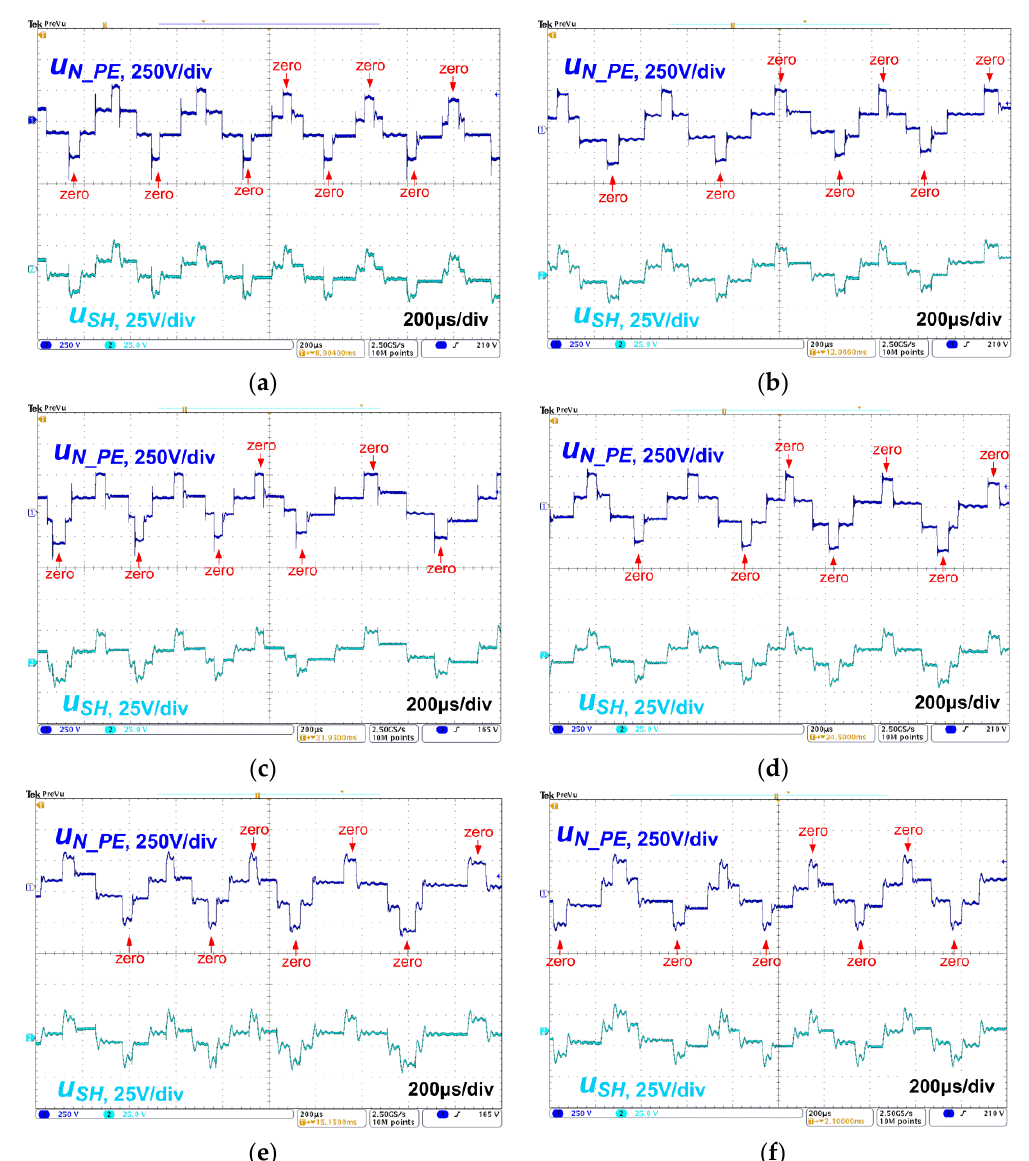
Figure 25. Experimental waveforms of CM voltage u N_PE and motor shaft voltage u SH measured in a configuration with a 10 m cable for: ( a ) inverter; ( b ) motor choke; ( c ) du/dt choke; ( d ) sine-wave filter; ( e ) CM choke; ( f ) CM choke with sine-wave filter.